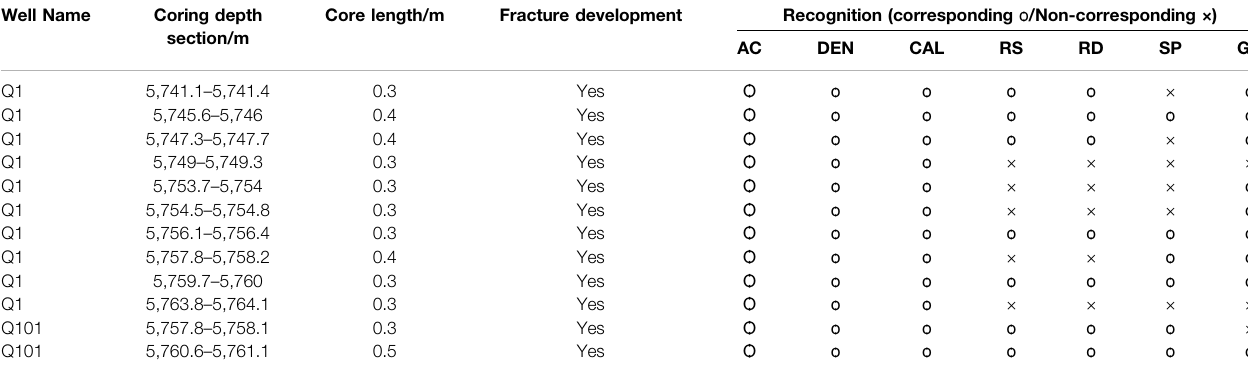
TABLE 1 | Recognition effect of various logging curves on the fracture development depth of the coring section. Well Name